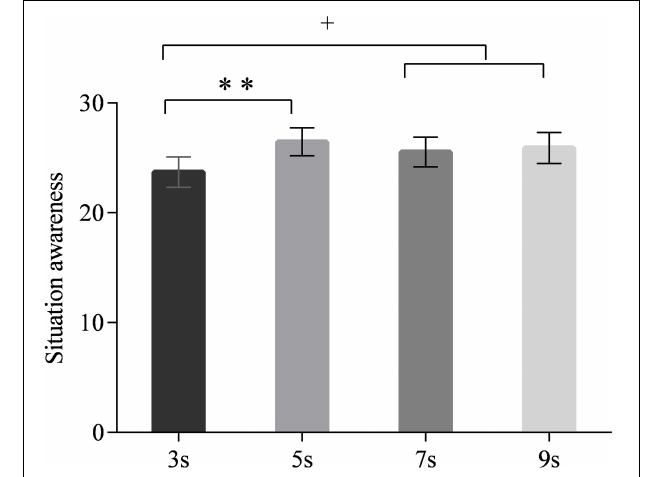
FIGURE 5 | Takeover time for drivers with low and high neuroticism under different time intervals. (Notes. * p < 0.05).